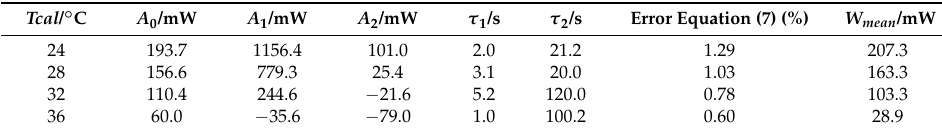
Figure 6. Calorimetric signal adjustment (experimental curve in blue and calculated curve in green). Results of the body heat flux (right hand of a healthy 23-year-old male subject) for three different thermostat temperatures: ( A ) 28 ◦ C, ( B ) 32 ◦ C and ( C ) 36 ◦ C. Figure 5 represents the complete measurements. Table 2. Coefficients and time constants of the heat flux (Equation (5)) of the human body (right hand of a healthy 23-year-old male subject) for four thermostat temperatures ( Tcal ). Tcal / ◦ C A 0 /mW A 1 /mW A 2 /mW τ 1 /s τ 2 /s Error Equation (7) (%) W mean